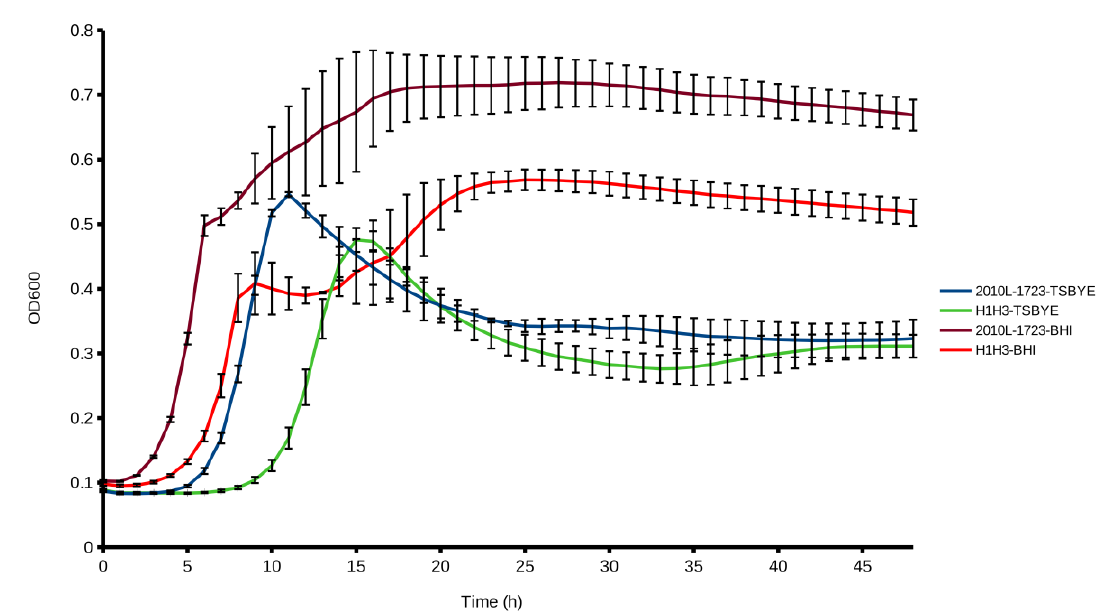
Figure 4. Aerobic growth of 2010L-1723 and H1H3 at 37 °C. Parental strain 2010L-1723 was grown in TSBYE (blue line) or BHI (orange line), and H1H3 was also grown in TSBYE (purple line) or BHI (green line) as described in the Material and Methods. Curves were generated from repeated measures of OD 600 over 48 h. Each line represents the average measures of four biological replicates per strain in one representative trial. Error bars represent standard deviation.